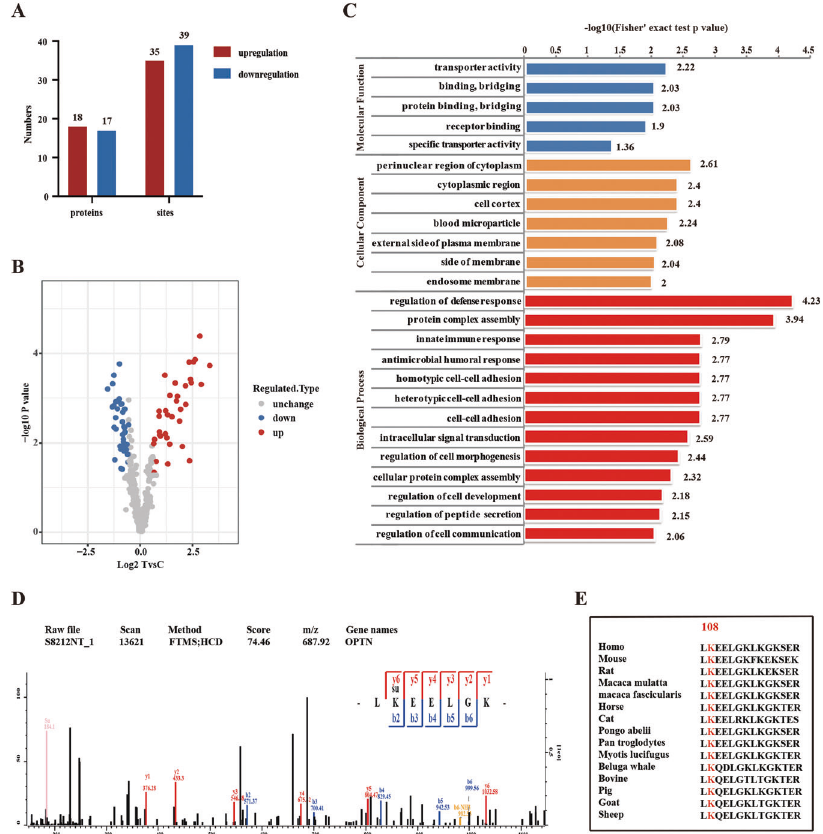
Fig. 2 Identi fi cation of differentially succinylated proteins between DR and IMH. A The number of differentially succinylated proteins or modi fi cation sites between the DR and IMH groups. Quantitative data with a p value < 0.05 and ratio >1.5 or <0.667 were considered differential succinylation. B Volcano plot of differentially succinylated modi fi cation sites between the DR and IMH groups. C Histogram of GO enrichment analyses based on the cellular component, molecular function and biological process categories of differentially succinylated proteins. D MS spectrum of the succinylated OPTN K108 site. E The K108 site is highly conserved in different species, ranging from mice to humans. DR diabetic retinopathy, IMH idiopathic macular hole, GO Gene Ontology, K